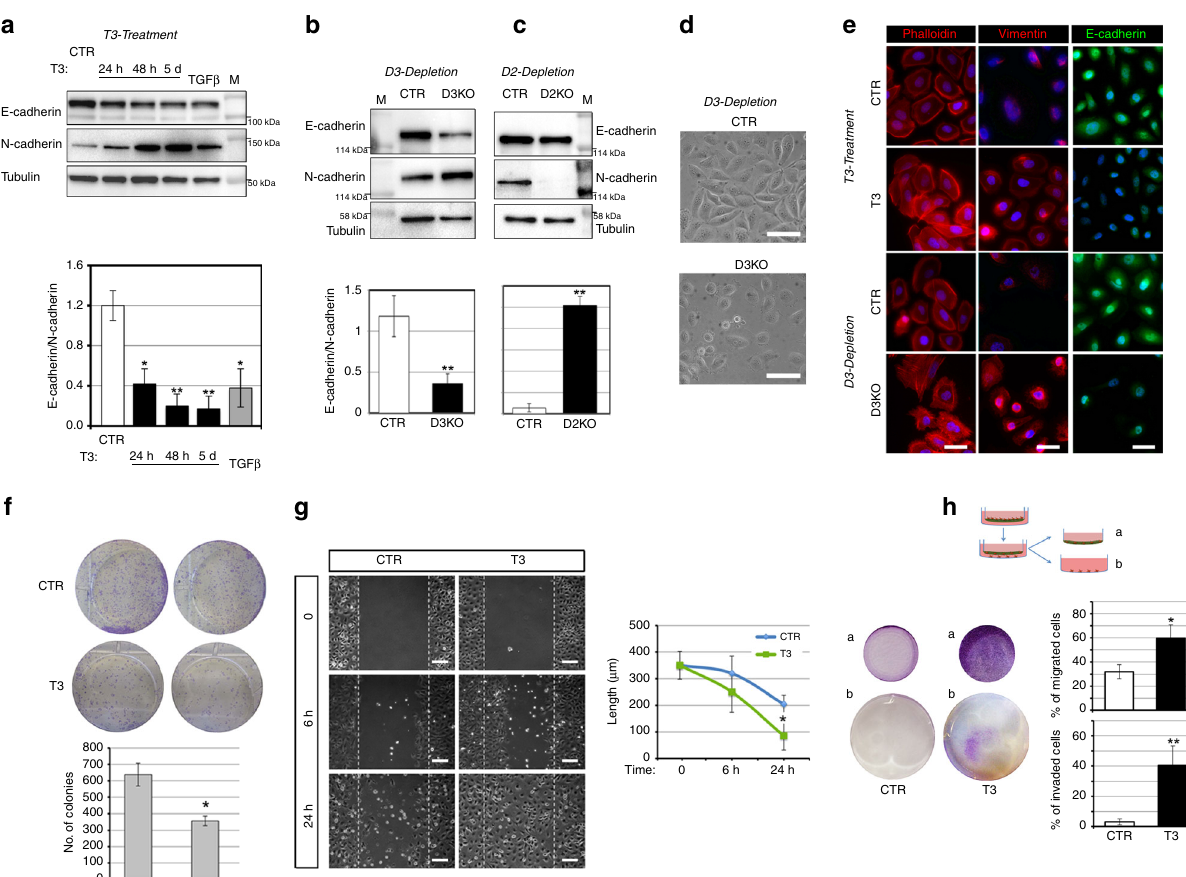
Fig. 5 Thyroid hormone activation induces the epithelial – mesenchymal transition and migration and invasion ability of SCC cells. a SCC cells were treated with 30 nM T3 for different time points or with 5 ng/ μ l TGF β for 48 h. Total protein lysates were used for western blot analysis of E-cadherin and N- cadherin expressions. Tubulin expression was measured as loading control. One representative immunoblot of seven is shown (top). Quanti fi cation of the E-cadherin/N-cadherin ratio in the western blot is represented by histograms. b Western blot analysis of E-cadherin and N-cadherin expressions performed as indicated in a in SCC-CTR and SCC-D3KO cells. c Western blot analysis of E-cadherin and N-cadherin expressions in SCC-CTR and SCC- D2KO cells. d Representative phase contrast of CTR and D3KO cells. Scale bars represent 50 μ m. e Phalloidin (red), Vimentin (red), and E-cadherin staining (green) of untreated and T3-treated SCC cells, SCC-CTR cells, and SCC-D3KO cells. One representative experiment of 5 is shown. Scale bars represent 50 μ m. * P < 0.05, ** P < 0.01. f Cell proliferation was assessed by colony assay of SCC cells treated or not with 30 nM T3 (top). The number of colonies formed 8 days after plating shown by scale bars (Bottom). One representative assay of fi ve is shown. g Wound scratch assay was performed in SCC cells after treatment with T3 (30 nM) for 0, 6, and 24 h. Cell migration was measured as described in the “ Methods ” section. Scale bars represent 200 μ m. h Invasion assay performed on SCC cells treated or not with 30 nM T3 for 5 days. (b) Represents cells that invaded on the receiver plate and the area covered by invaded cells is indicated. The percentage of cells that migrated and invaded are represented by